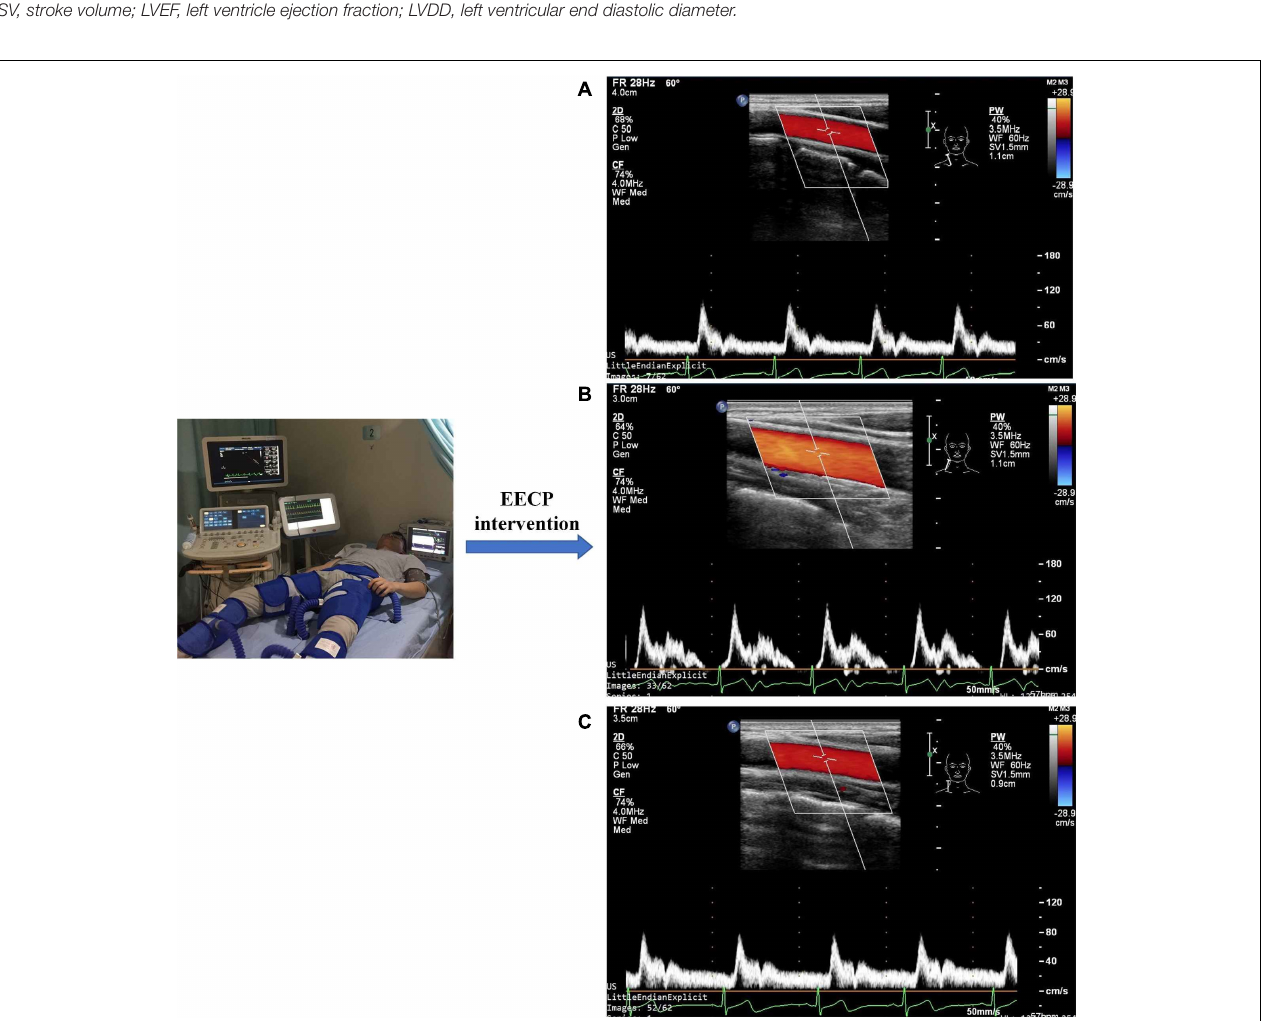
Frontiers in Physiology |